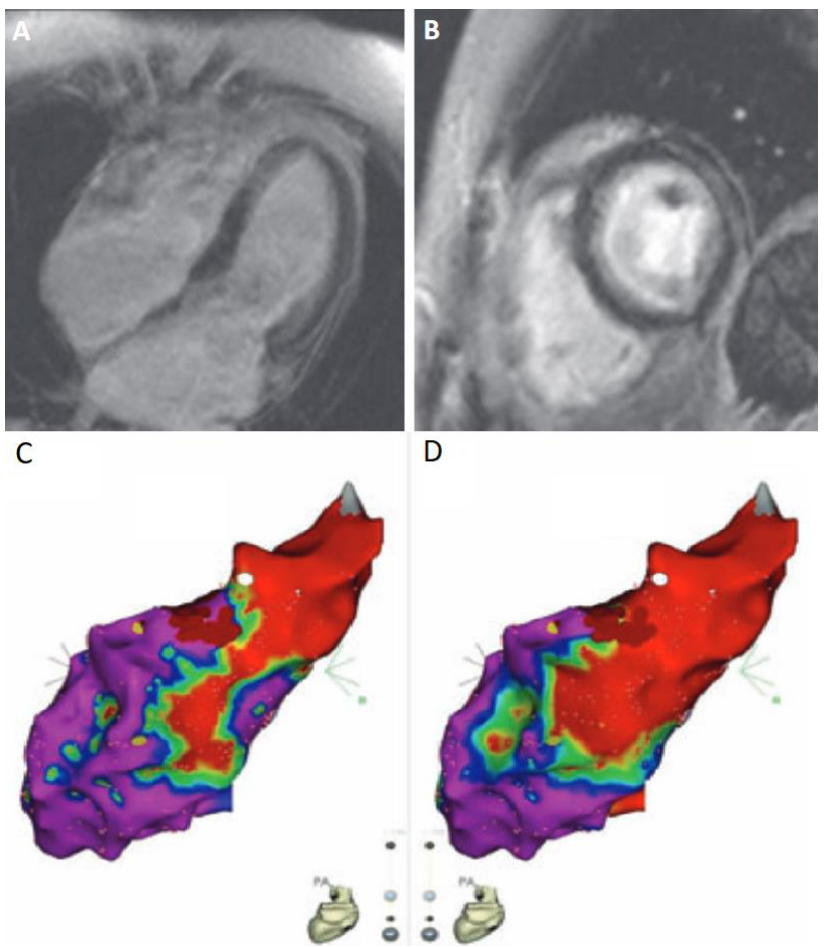
Figure 3. Joint application of cardiac magnetic resonance (CMR) and electro-anatomical mapping (EAM) in the case of a 43 year old female diagnosed with Behçet’s disease and high burden of symptomatic ventricular extrasystoles (≈20,000 on 24 h ambulatory electrocardiography), without LV dysfunction. ( A , B ) T1-weighted sequence CMR with obvious LGE both at the left ventricular lateral wall (midmyocardial) and subendocardially (diffuse pattern, not corresponding to coronary artery territory). Four chamber ( A ) and short axis ( B ) views. ( C , D ) Electroanatomical map of the LV using the CARTO3® system (Biosense-Webster, Diamond Bar, CA, USA) depicting a low voltage area (non-purple color) in the same segments, using both bipolar ( C ) and unipolar ( D ) settings. Successful ablation of the arrhythmia was achieved following radiofrequency energy application at the basal lateral wall, an area with abnormal unipolar but not bipolar voltage values, suggesting a nonsubendocardial arrhythmogenic focus [116].